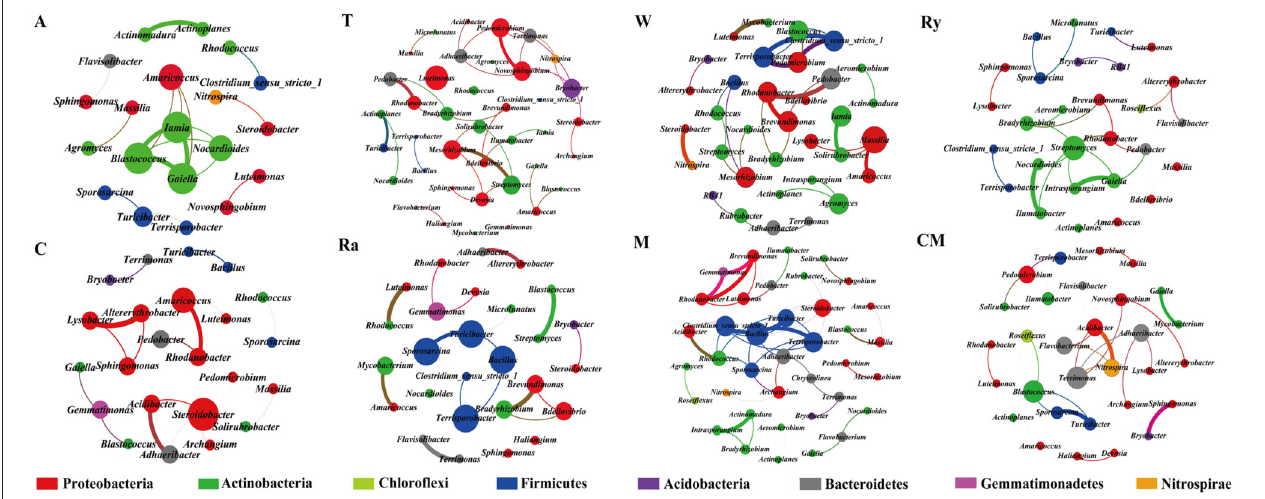
FIGURE 6 | Network of co-occurring bacterial genera based on correlation analysis for intercropping cultivations and cucumber monoculture. A connection stands for a strong (Spearman’s ρ > 0.6) and significant ( P < 0.01) correlation. The size of each node is proportional to the degree, the thickness of each edge is proportional to the value of Spearman’s correlation coefficients. Nodes colored by taxonomy.